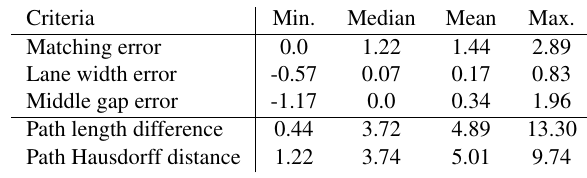
Figure 8. Overall error